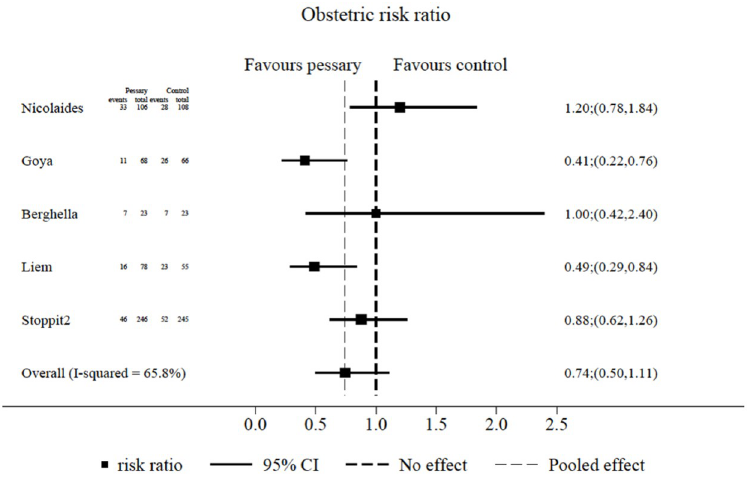
Fig 2. Meta-analysis of STOPPIT-2 and published data on the effectiveness of a cervical pessary in twin pregnancies in women with a short cervix in the prevention of preterm birth before 34 weeks gestation.